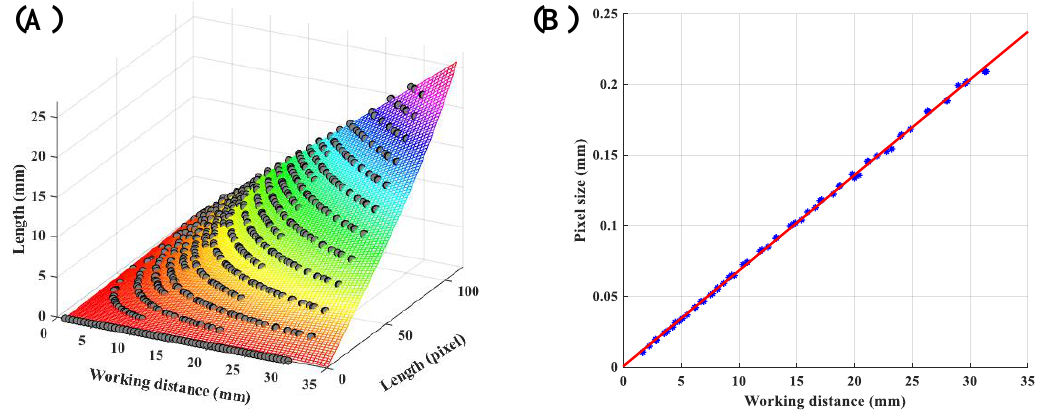
Figure 5. Models for horizontal measurements: (A) non-uniform model and (B) uniform model.